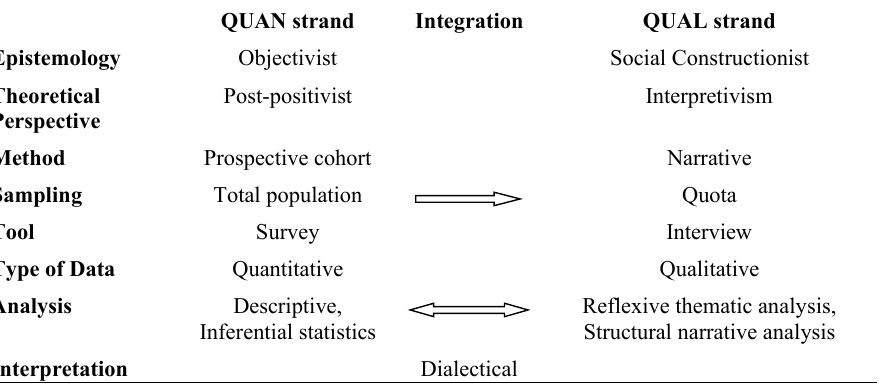
Figure 1. Research design of dialectical MM.